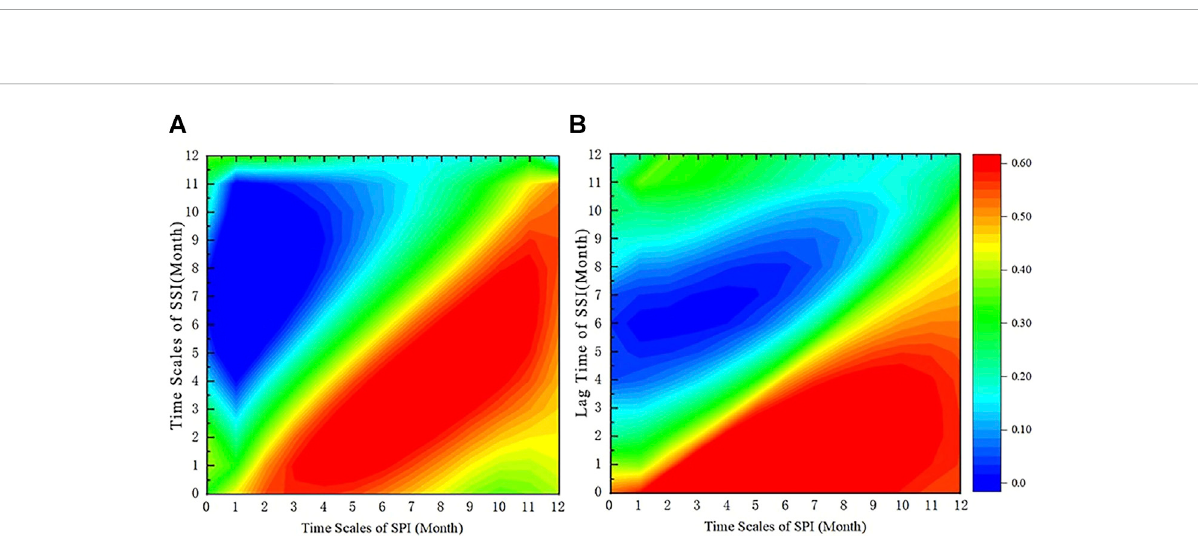
FIGURE 6 Meteorological and hydrological drought events in different seasons.